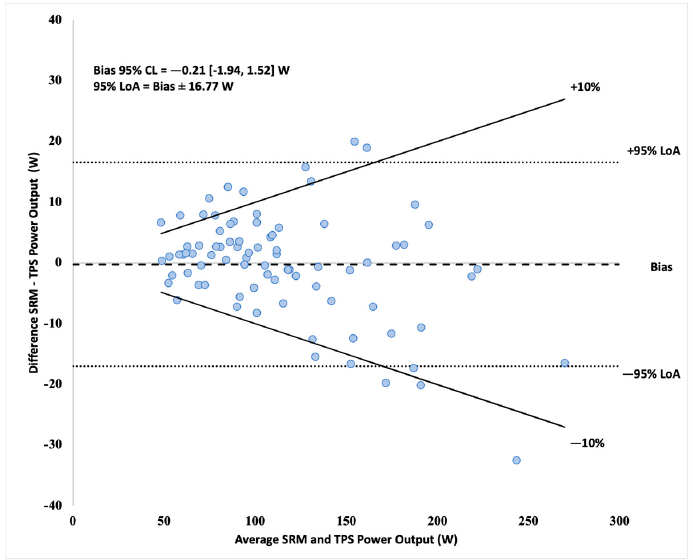
Figure 5. Bland–Altman plot with 95% LoA of 1 min averaged data between devices. Table 3. Comparison of trial 1-minute average by device.